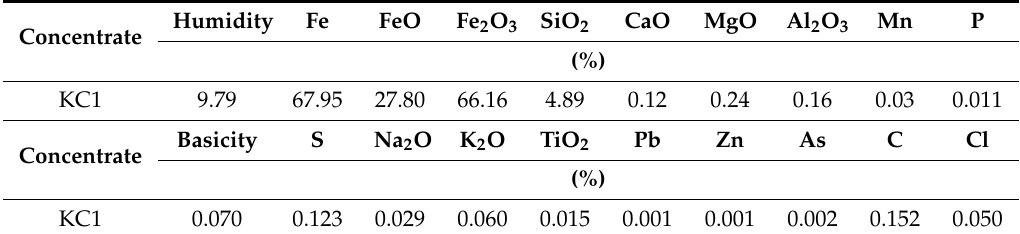
Table 2. Chemical composition of concentrate used in